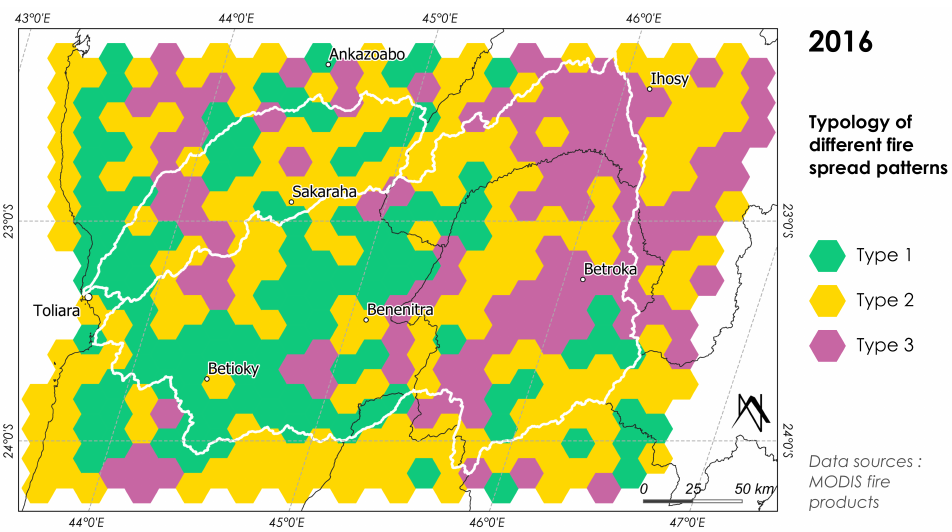
Figure 5. Residuals mapping, focus on the year 2016. Each year between 2001 and 2018 are available in (Appendix D).